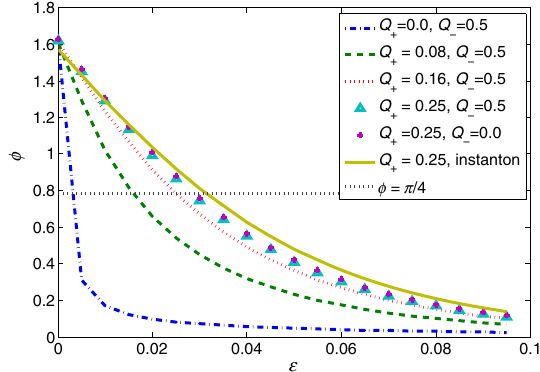
FIG. 6. The relative phase acquired between states of the qubit after the phase gate is enacted, here plotted as a function of the Josephson junction asymmetry ϵ for a strong junction that is twice as strong as the weak junctions ( λ ¼ 2 ). The charging energy E has been chosen to be 0.4 relative to the scale of the C Josephson energy ð J 1 þ J 2 Þ = 2 . The sum and difference of the gate charges [ Q ¼ ð Q 1 þ Q 2 Þ and Q − ¼ Q 1 − Q 2 ] are ex- þ pressed in units of the Cooper pair charge 2 e . Note that a relatively small junction asymmetry of ϵ ≤ 0 . 1 can tune the gate through a large range of